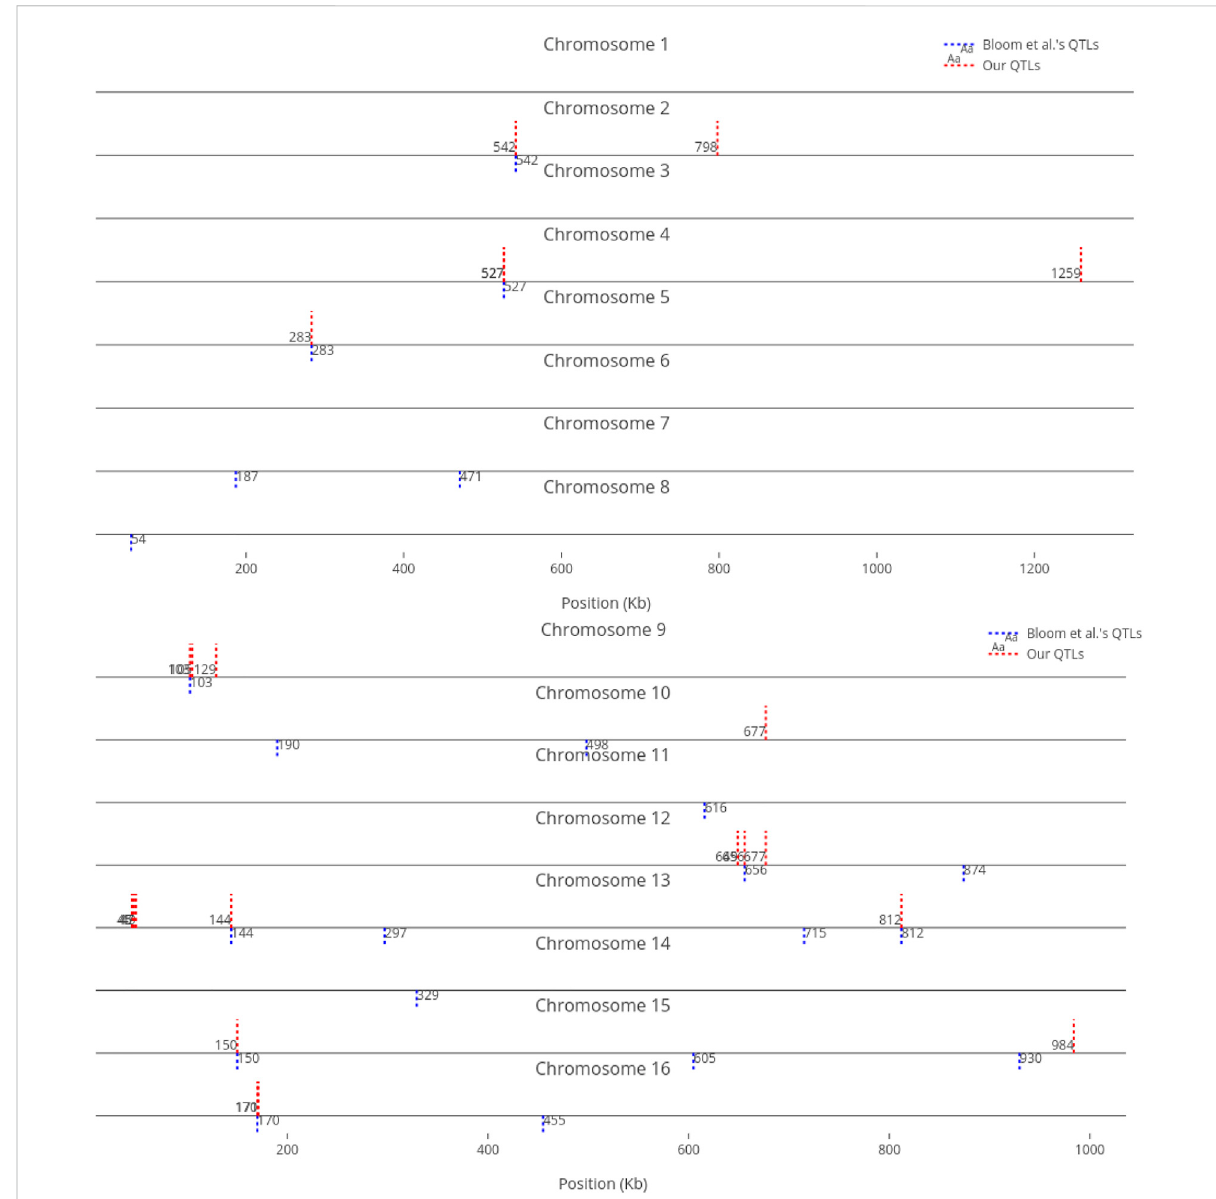
FIGURE 3 Top 22 in fl uential markers on growth in Lithium Chloride recognized by ensemble RVMs versus Bloom et al. ‘ s 22 QTL. (To view the improved version of (b) follow the link:(b) - Interactive